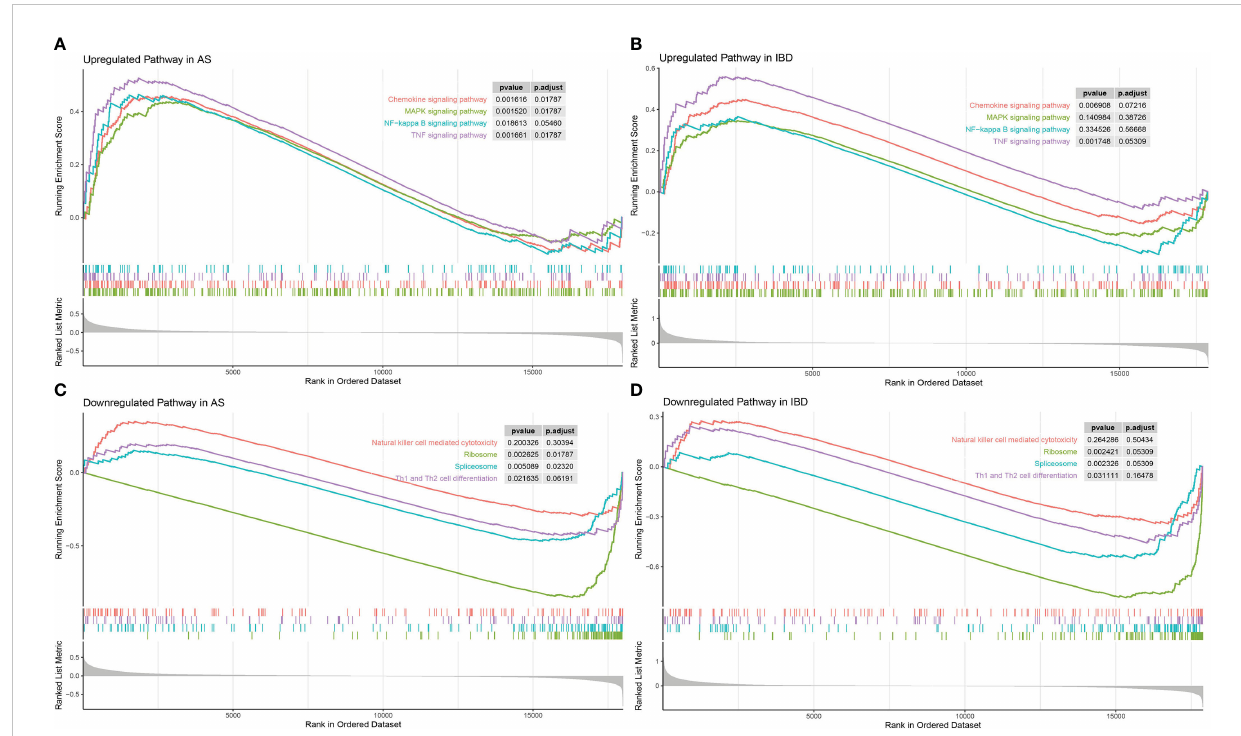
FIGURE 5 GSEA of signi fi cant common differential pathways in AS and IBD (A) GSEA of “ MAPK signaling pathway ” , “ Chemokine signaling pathway ” , “ TNF signaling pathway ” , “ NF- k B signaling pathway ” in AS. (B) GSEA of “ MAPK signaling pathway ” , “ Chemokine signaling pathway ” , “ TNF signaling pathway ” ,